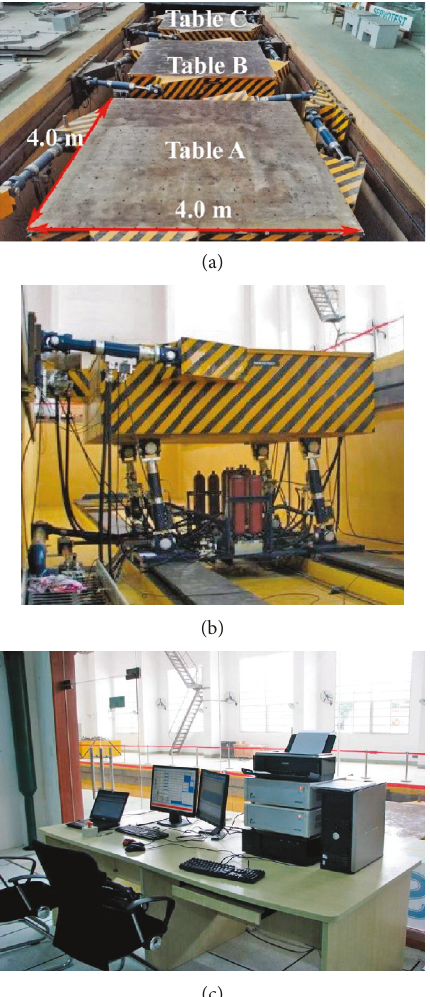
Figure 1: Laboratory multifunction shaking table system. (a) Three tables and horizontal actuators. (b) Vertical actuators. (c) Control